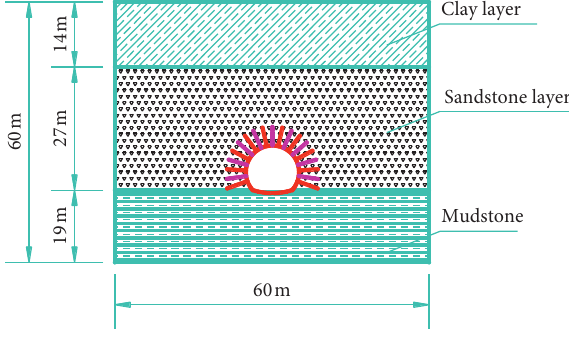
Figure 5: Model size diagram.